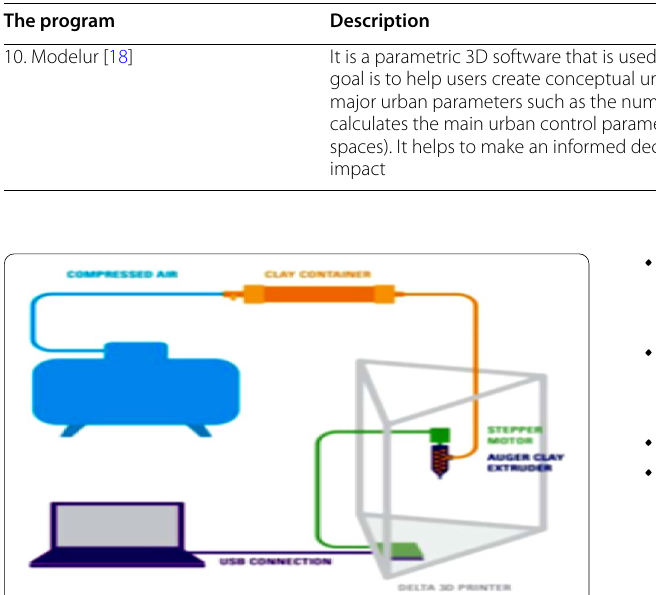
Fig. 1 An illustration of the components of the 3D printing